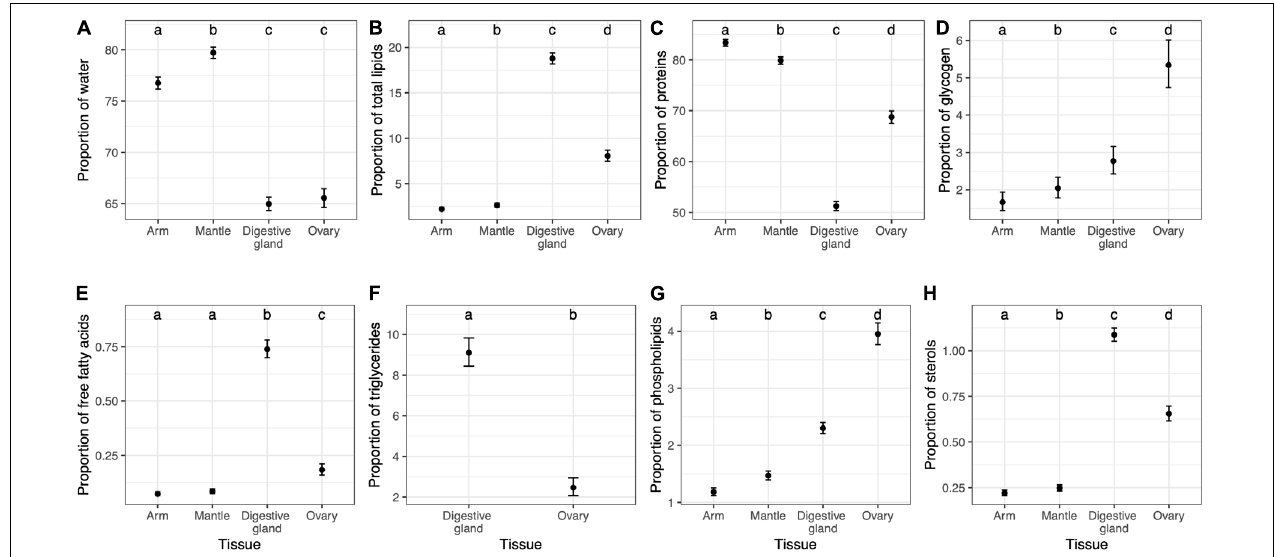
FIGURE 2 | Average values ( ± 95% C.I.) in % for water (A) and % of dry weight (DW) for the other biochemical constituents (B–H) measured in each of the four tissues (with the exception of triglycerides). Dots with shared letters on top indicate non-significant differences as evaluated with a beta regression